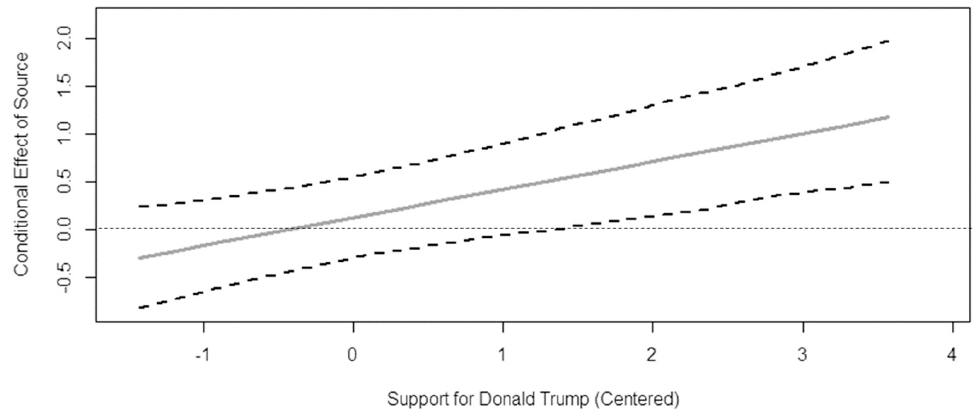
Figure 4. Effect of source on name change support (financial) by the degree of Trump support with 95% confidence inter- vals .